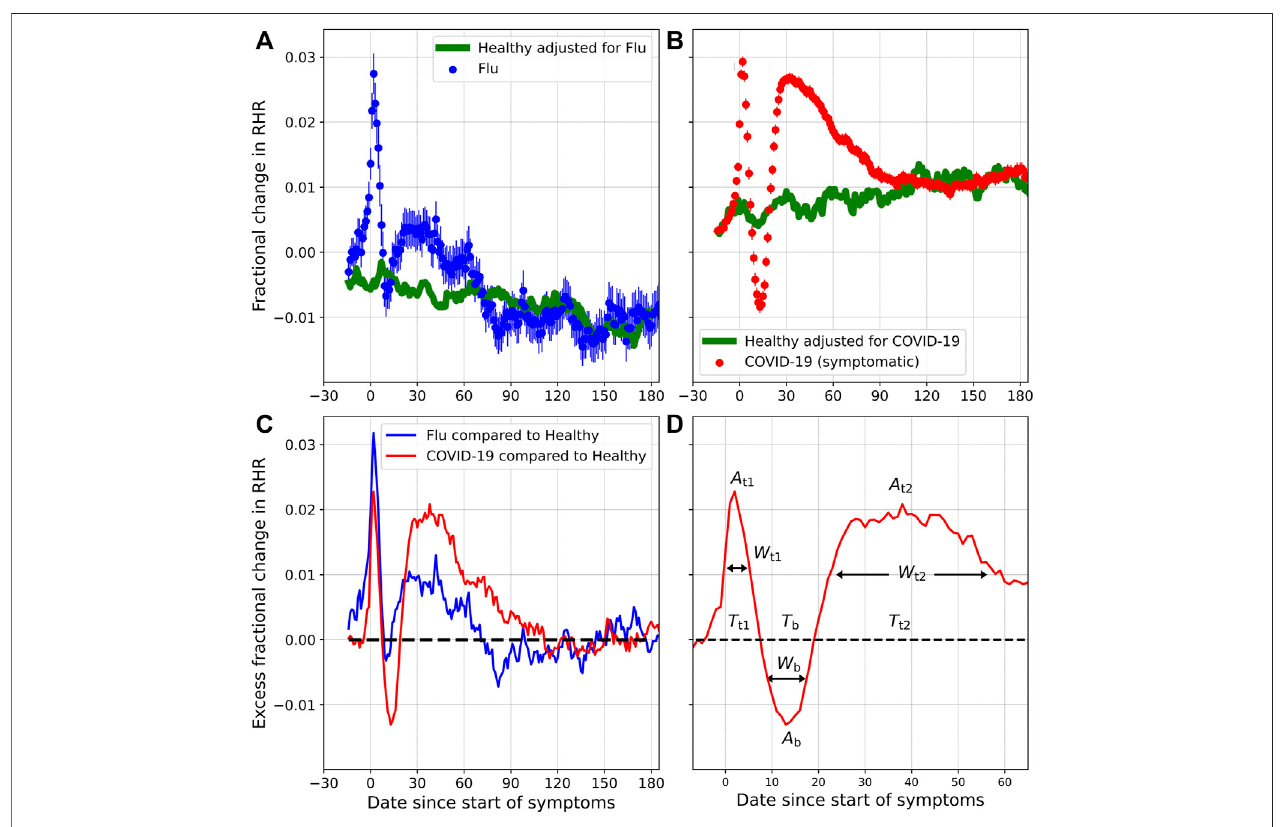
FIGURE3| FractionalchangeinRHR( ξ ),forindividualsdiagnosedwith fl u (A) andCOVID-19 (B) ,alongwiththeexpectedseasonalvariation( ξ control ). (C) showsthe excessfractionalchangeinRHR( Δ ξ )for fl uandCOVID-19,oncethecontributionofseasonalityhasbeensubtracted. (D) showsthevariousparameterstobeestimated.